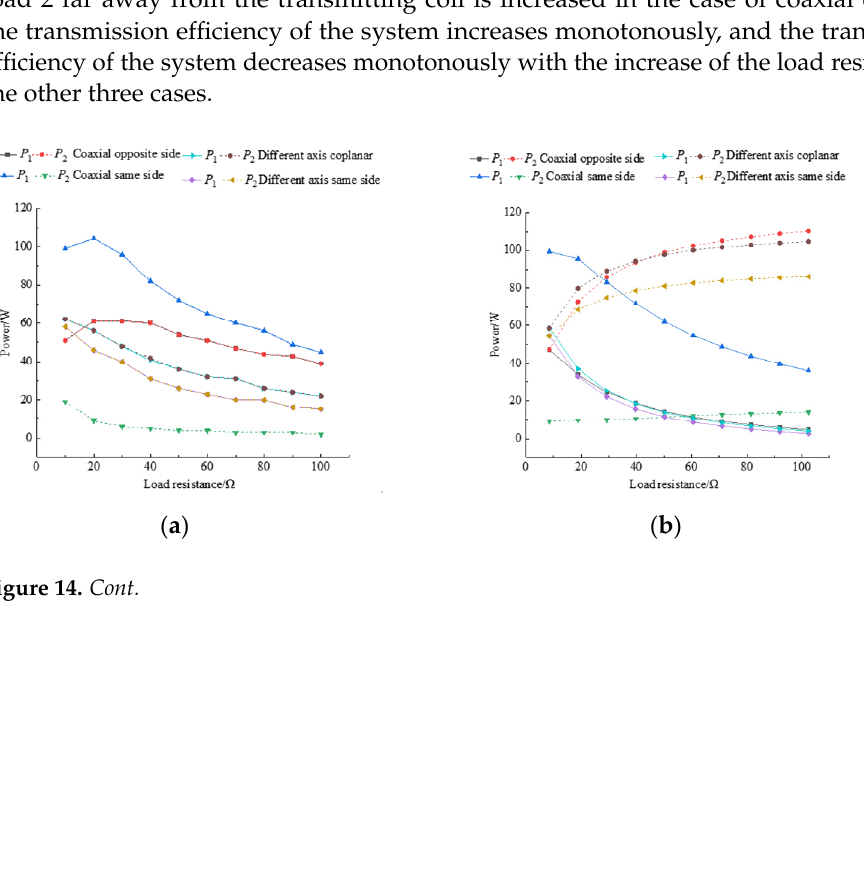
Figure 14. Load resistance and system parameter curves. ( a ) Double load synchronous change. ( b ) Only load 1 changes. ( c ) Only load 2 changes on the same side of the coaxial. ( d ) Efficiency curve. 6. Conclusions This paper analyzes and verifies the coupling characteristics of the dual-load wireless power transmission system in the four cases of coaxial different sides, coaxial same side, different axis same side, and different axis coplanar coil positions in space. The specific conclusions are as follows. (1). When the distance between the receiving coils of the dual-load radio transmission system is close, the cross coupling between the receiving coils will reduce the trans-